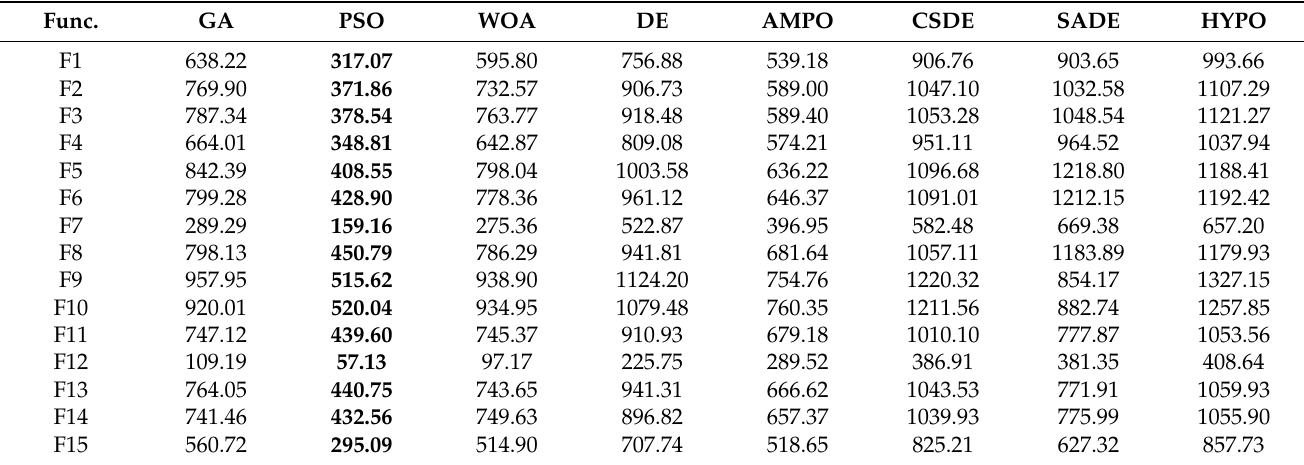
Table 4. The CPU Time Comparison on the CEC2019 Set.